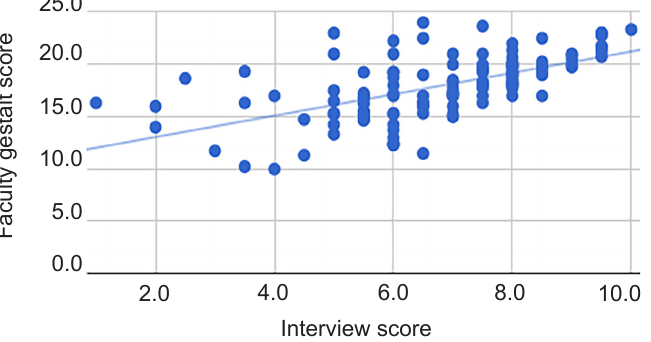
Figure 3. Scatter plot of faculty gestalt score vs. interview score (r (123)=0.65, p<0.01), with line of best s